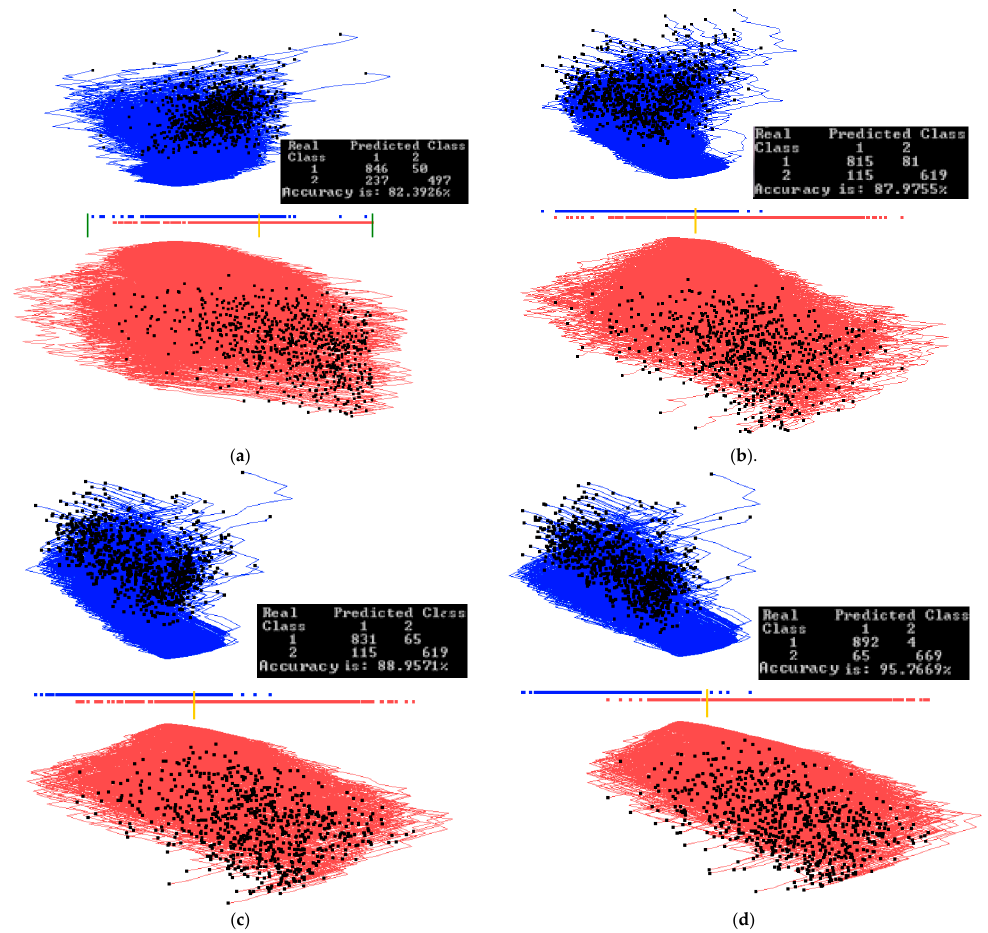
Figure 16. Experiments with a 900 samples of MNIST dataset for digits 0 and 1 doing automatic dimension reduction. ( a ) Data between the two green thresholds are visualized and projected; ( b ) GLC-AL algorithm on the subinterval to find a better projection. Accuracy goes up by 5.6% in the